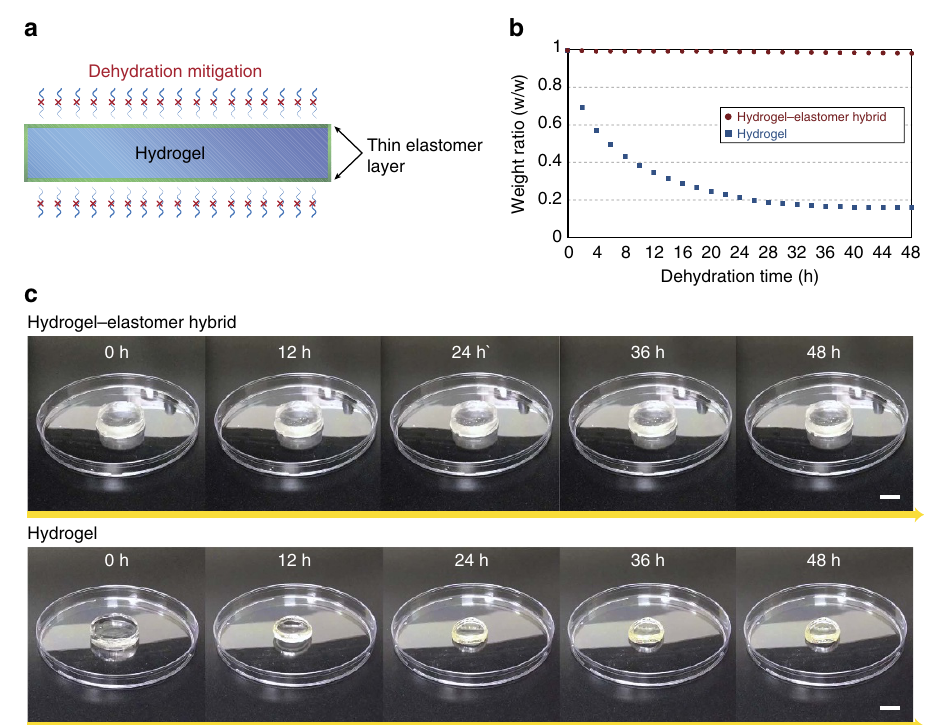
Figure 4 | Anti-dehydration hydrogel–elastomer hybrid. ( a ) Schematic illustration of the anti-dehydration elastomeric coating for hydrogels. A very thin layer of Ecoflex elastomer robustly bonded to the hydrogel can effectively prevent evaporation of water from the hydrogel. ( b ) The hydrogel–elastomer hybrid does not show noticeable change in its weight under the ambient testing conditions (24 (cid:2) C and 50% humidity) for 48h; whereas hydrogel without elastomeric coating loses most of its water content after 48h. ( c ) Snapshots of the hydrogel–elastomer hybrid and hydrogel during the dehydration experiments. Scale bar, 10mm ( c